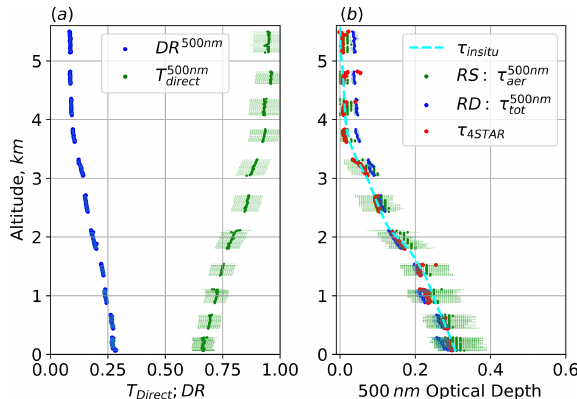
Figure 5. ORACLES spiral on 5 October 2018. (a) DR 500nm mea and T 500nm with the associated measurement uncertainty shown by the shading; (b) τ aer profiles derived from RS, 4STAR, in situ, and